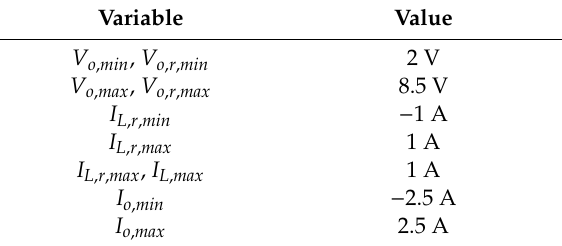
Table 3. Voltage subsystem marginal